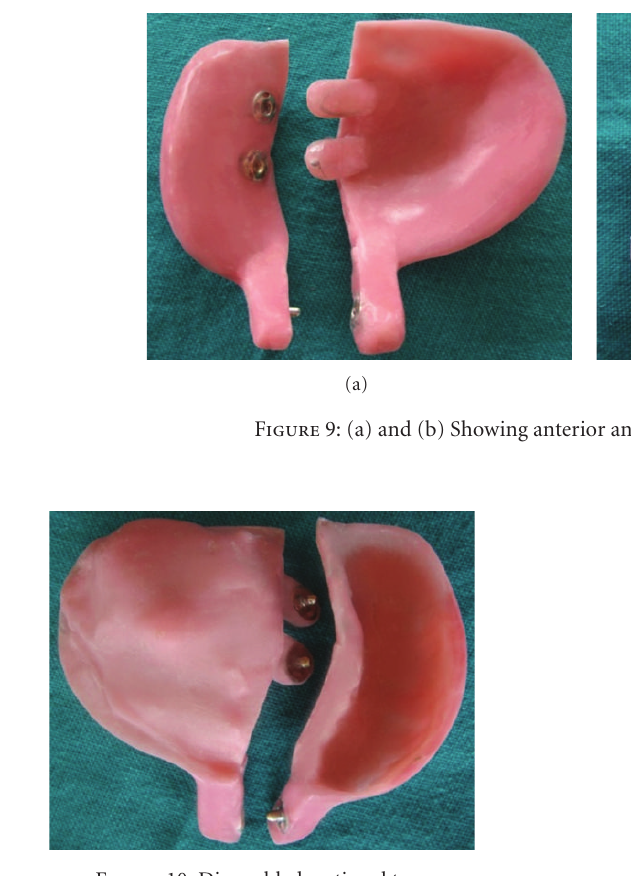
Figure 10: Dissembled sectional tray.